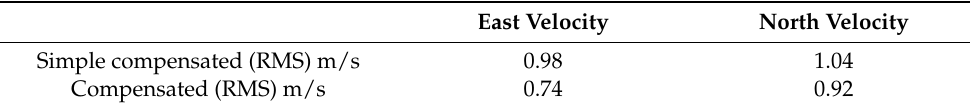
Figure 9. ( a ) is the comparison of east velocity error in laboratory test; ( b ) is the comparison of north velocity error in laboratory test. Table 6. Comparison of velocity error in laboratory experiment.